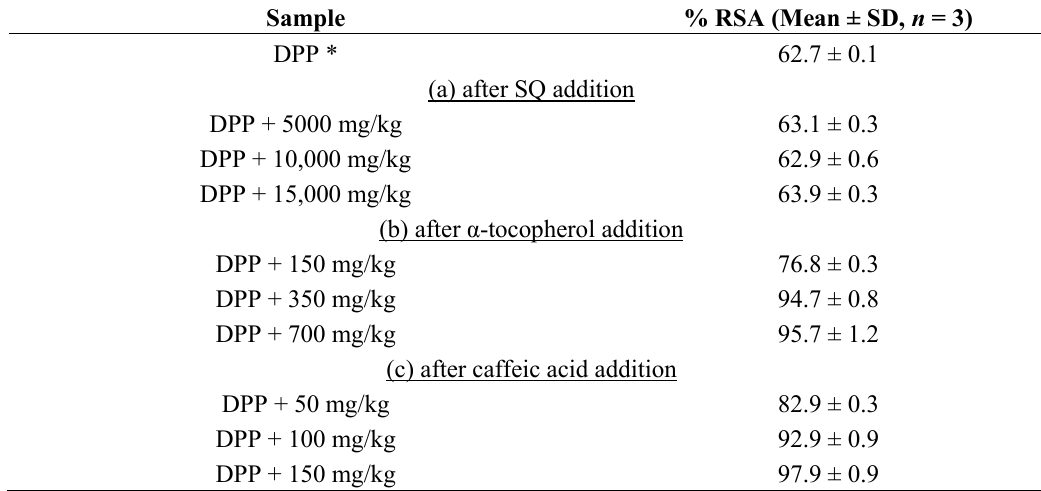
Table 4. Radical scavenging activity (RSA) of an olive oil devoid of polar phenolic compounds (DPP) after the addition of squalene, α -tocopherol or caffeic acid at realistic levels (Naziri and Tsimidou)